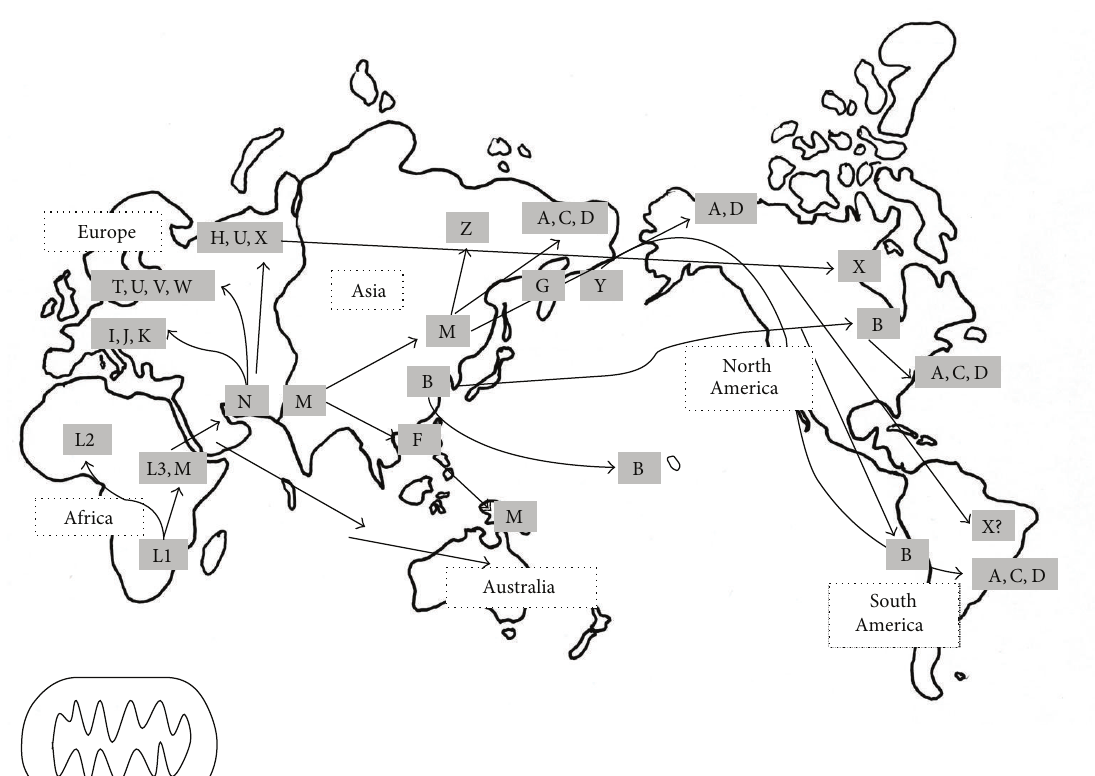
Figure 1: MtDNA haplogroup migration patterns. The map shows the migration patterns of the main mtDNA haplogroups.